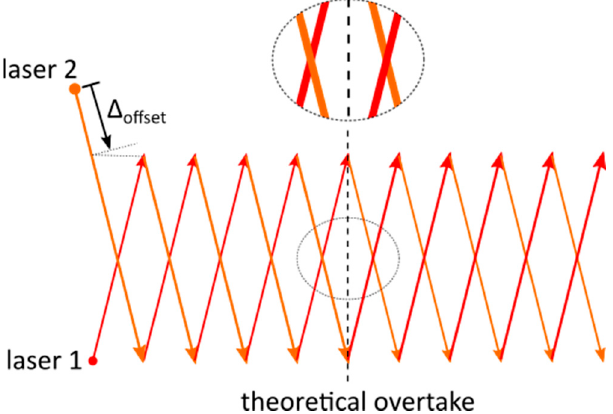
Figure 4. Illustration of procedure for temporal calibration.